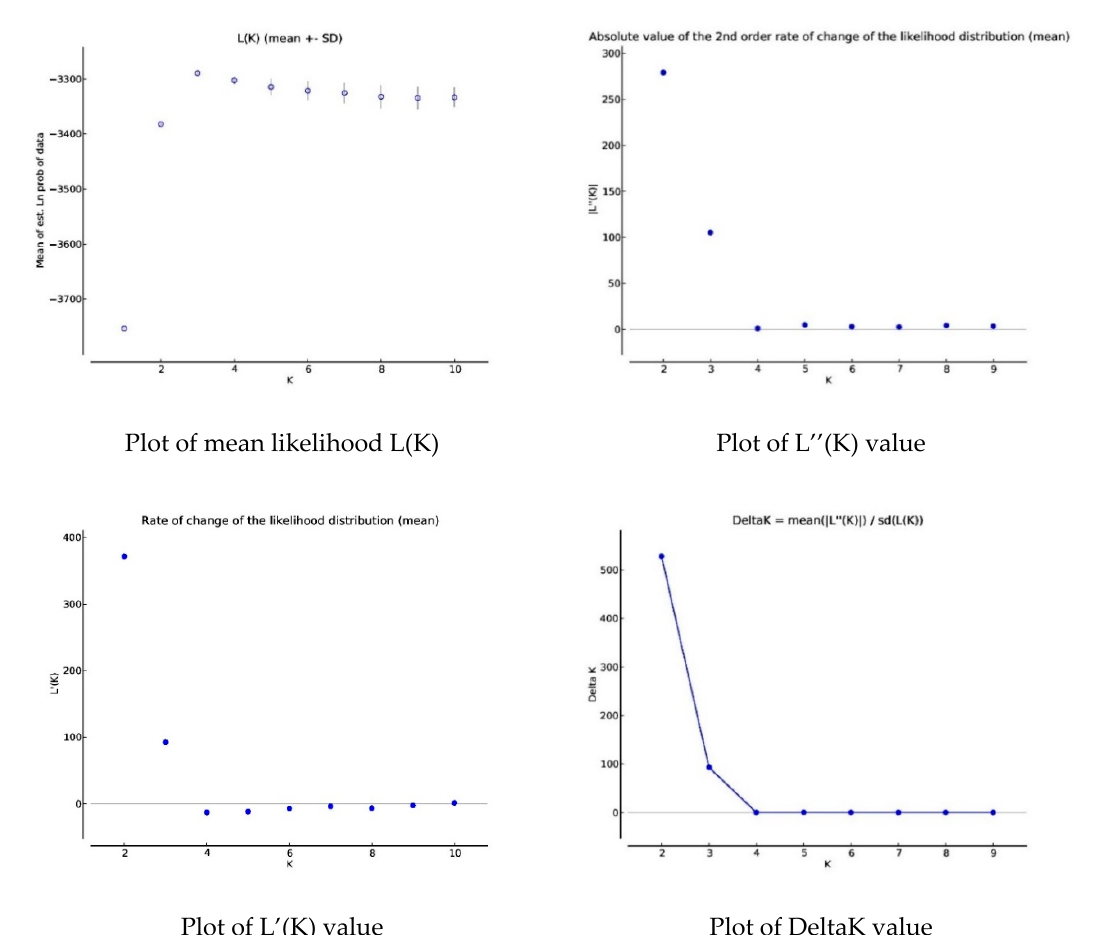
Figure 1. Evolution of the parameters estimating the value of K (likelihood).